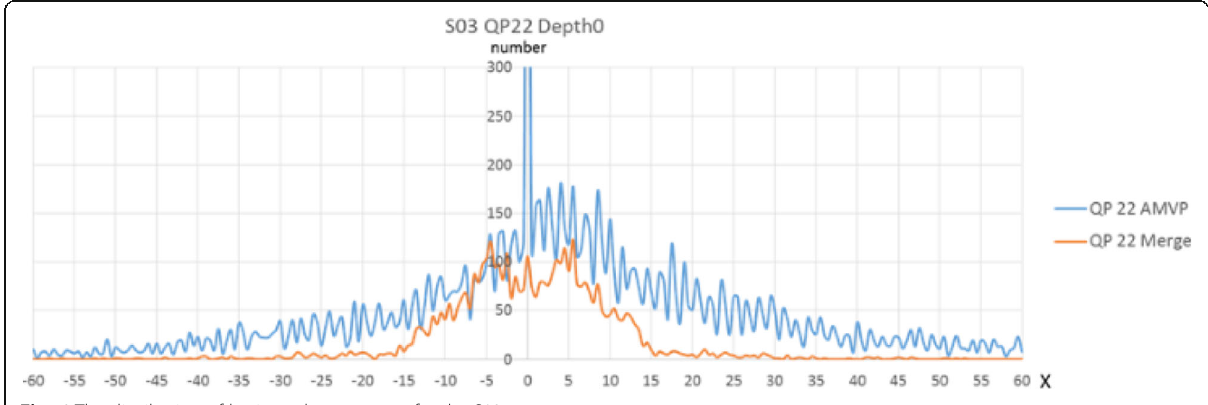
Fig. 6 The distribution of horizontal component for the S03 sequence